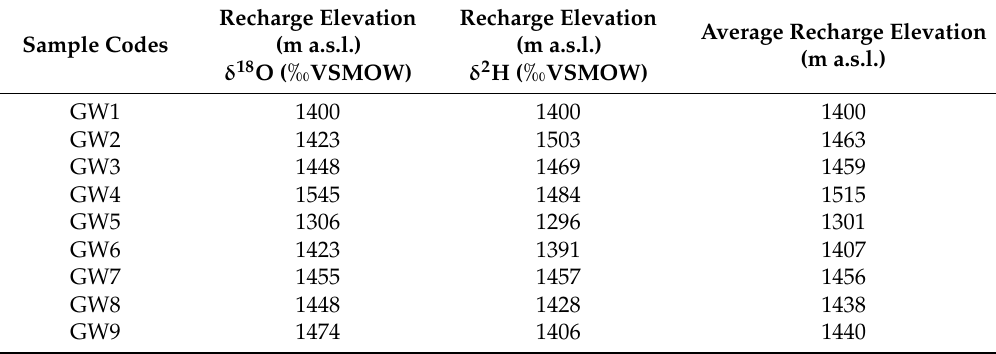
Table 4. Recharge elevation obtained by the application of the Center of Mass Method.